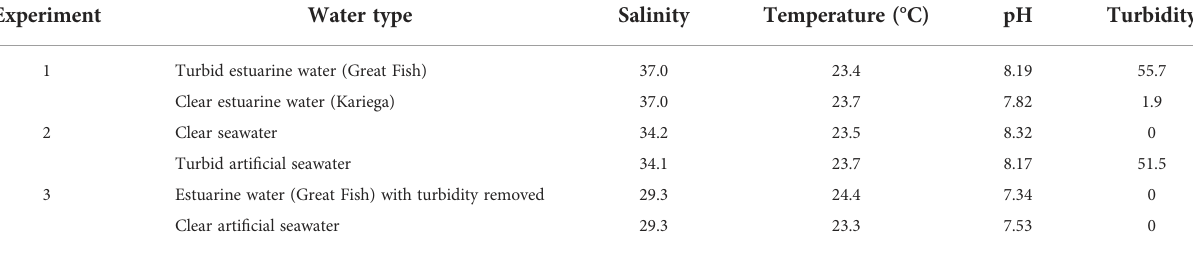
TABLE 1 Water parameters at the initiation of the choice chamber